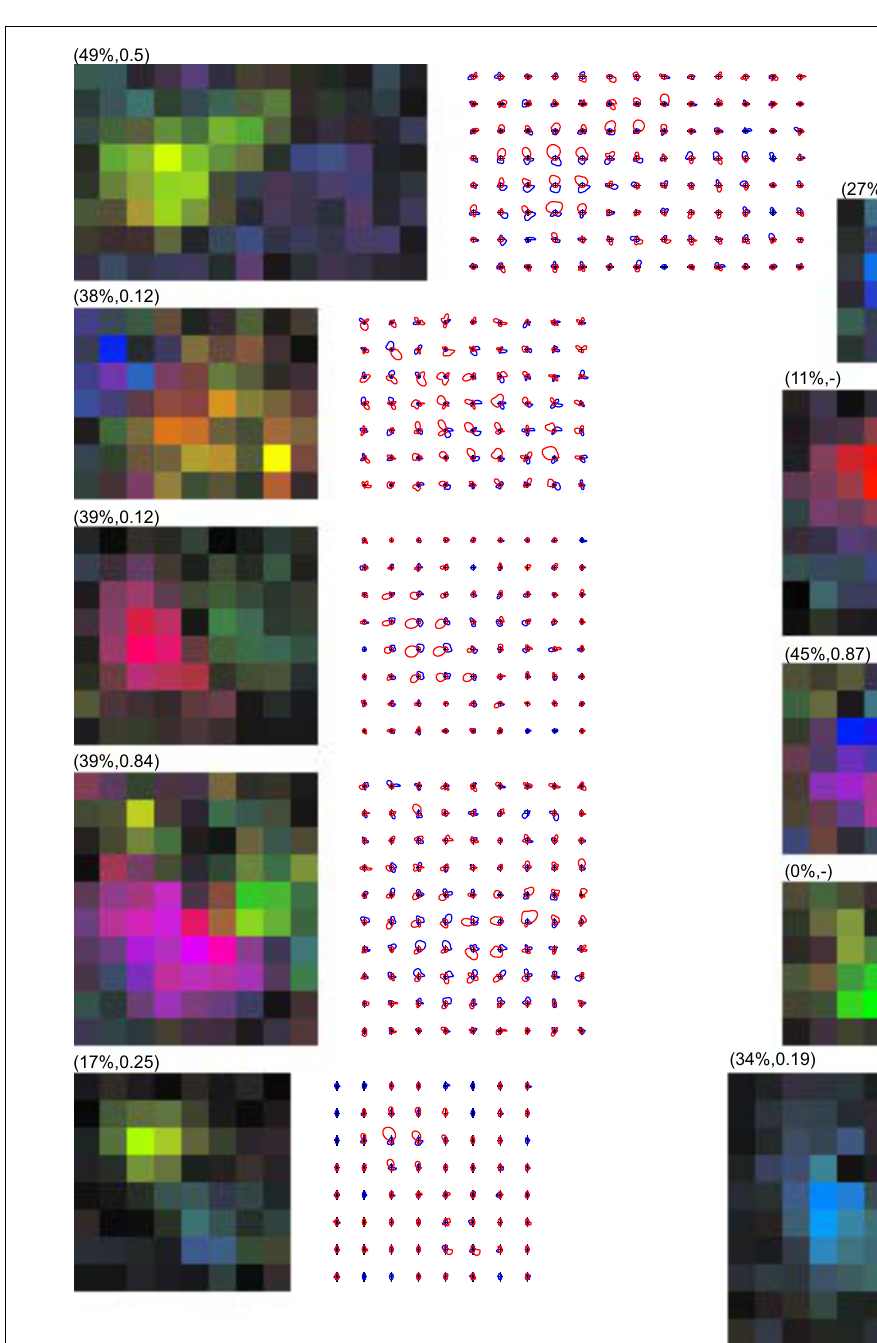
FIGURE 5 | Examples of MT neurons with multiple preferred directions. The RF maps were calculated at a 1˚ × 1˚ spatial resolution and cropped to leave a single pixel outside the bounding box of the RF.The color maps use the representation of Figures 1E,F .The matching line drawings show separate tuning curves for excitatory (red) and suppressive (blue) effects, following the representation of Figure 1D .The labels above the color maps show the waveforms, including the noise ( L -ratio = 0.001). This confirms that the same unit had different directional preferences in the two locations. These preferences were not the consequence of the